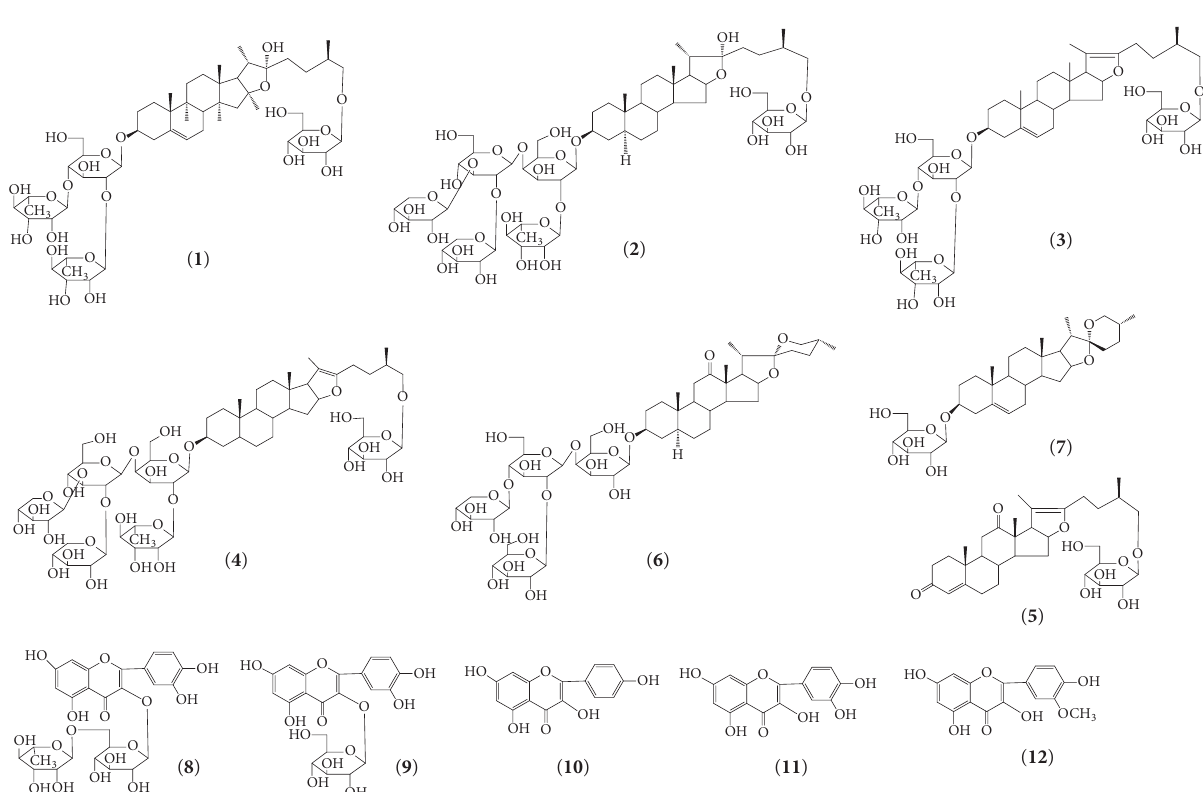
Figure 1: Chemical structures of the twelve bioactive components. (1) Protodioscin, (2) (25R)-26-O- 𝛽 -D-glucopyranosyl-5 𝛼 -furostan- 3 𝛽 ,22 𝛼 ,26-triol-3-O- 𝛽 -D-xylopyranosyl-(1 → 2)-[ 𝛽 -D-xylopyranosyl-(1 → 3)]- 𝛽 -D-glucopyranosyl-(1 → 4)-[ 𝛼 -L-rhamnopyranosyl-(1 → 2)]- 𝛽 -D-galactopyranoside, (3) Pseudoprotodioscin, (4) 26-O- 𝛽 -D-glucopyranosyl-(25R)-5 𝛼 -furostan-20(22)-en-3 𝛽 ,26-diol-3-O- {𝛽 -D-xylo- pyranosyl-(1 → 2)-[ 𝛽 -D-xylopyranosyl-(1 → 3)]- 𝛽 -D-glucopyranosyl-(1 → 4)-[ 𝛼 -L-rhamnopyranosyl-(1 → 2)]- 𝛽 -D-galactopyranoside } , (5) Terrestrinin A, (6) hecogenin-3-O- 𝛽 -D-glucopyranosyl(1 → 2)-[ 𝛽 -D-xylopyranosyl-(1 → 3)]- 𝛽 -D-glucopyranosyl-(1 → 4)- 𝛽 -D-galactopyra- noside, (7) Tibllin, (8) Rutin, (9) Isoquercitrin, (10) kaempferol, (11) quercetin, and (12)